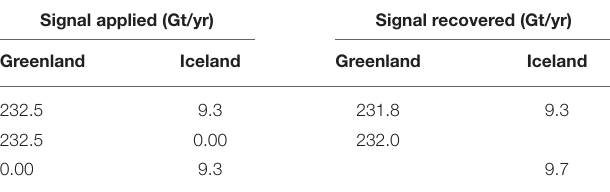
TABLE 3 | Synthetic trends recovered over each region with and without leakage from the other region.